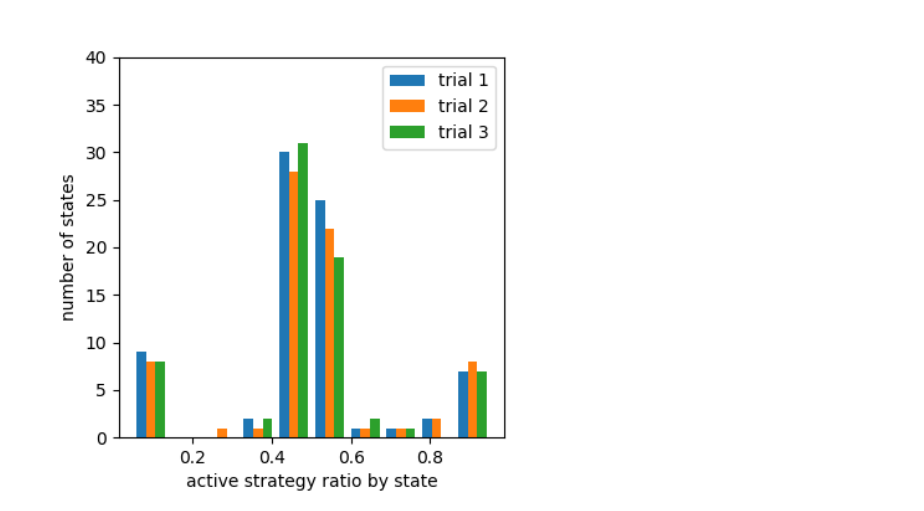
Figure 11. Percentage of active strategies chosen by state (cooperative rewards (0, 0), after active strategy is